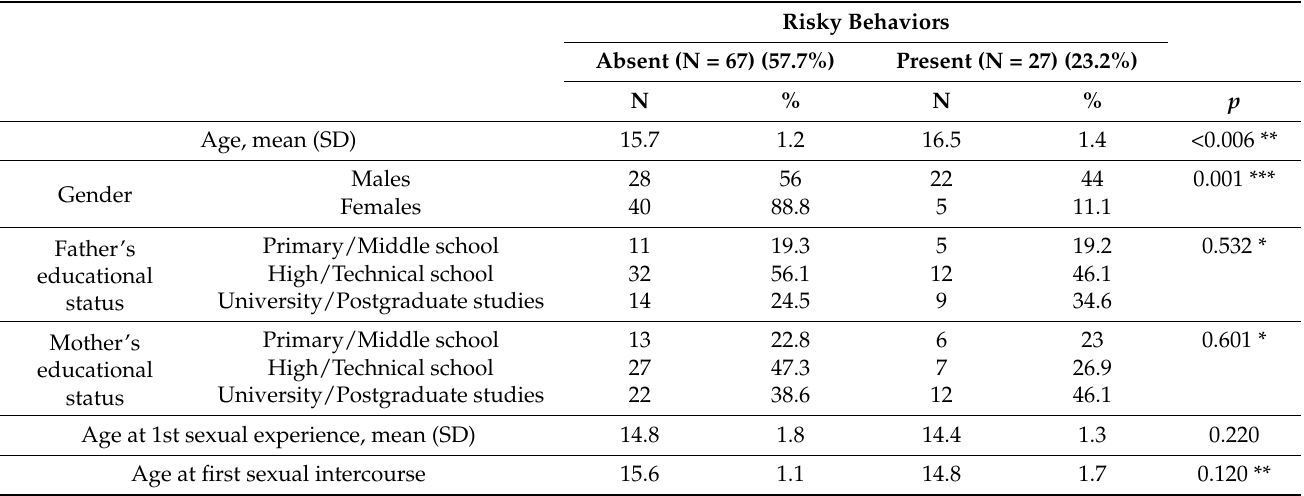
Table 5. Characteristics of adolescents without T1D according to the presence/absence of two or more risky